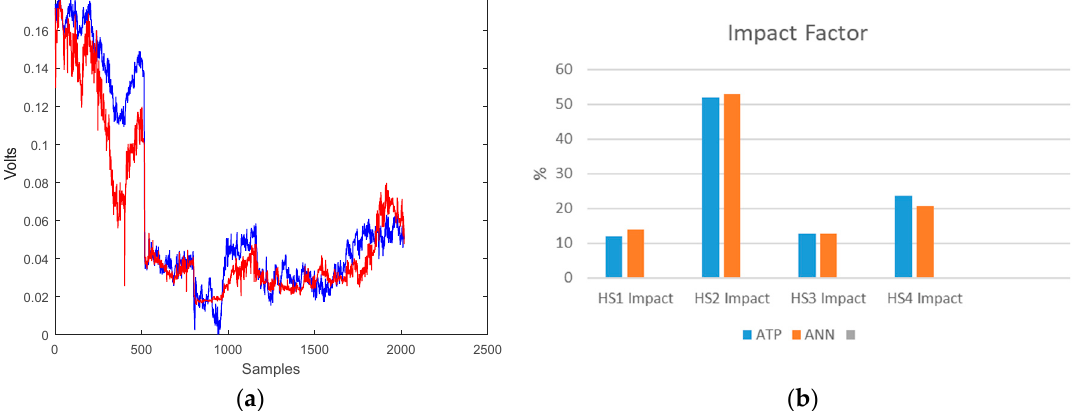
Figure 5. ( a ) Comparing ATP calculated fifth harmonic voltage magnitudes (in blue) at bus B03 with their estimates obtained by the ANN using the test set (in red); ( b ) comparing percent impacts obtained by ATP and ANN.